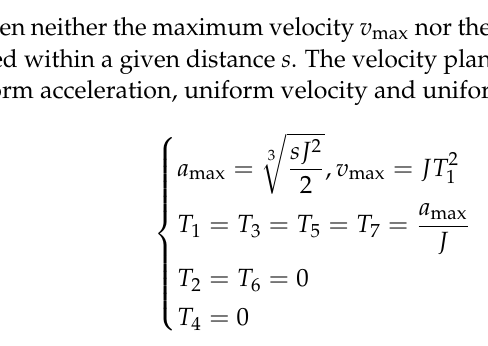
The S-velocity planning algorithm flow chart is shown in Figure 4.